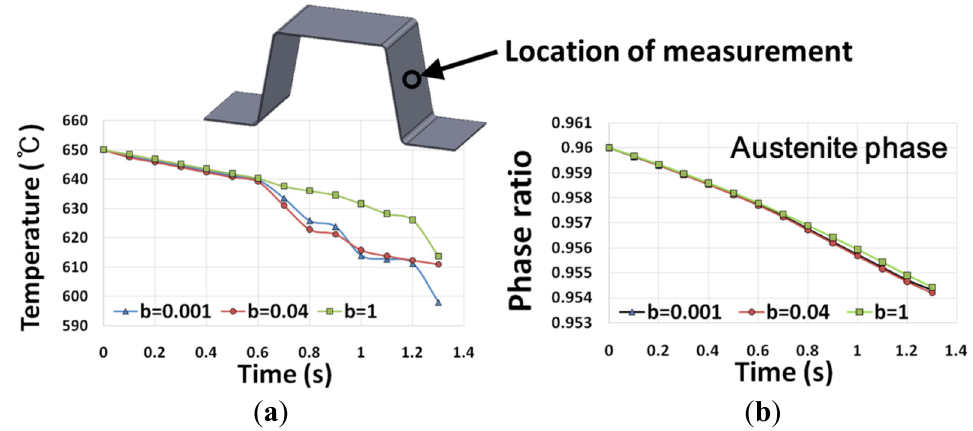
Figure 9. The evolutions of ( a ) temperature and ( b ) austenite phase ratio at a central location on the side